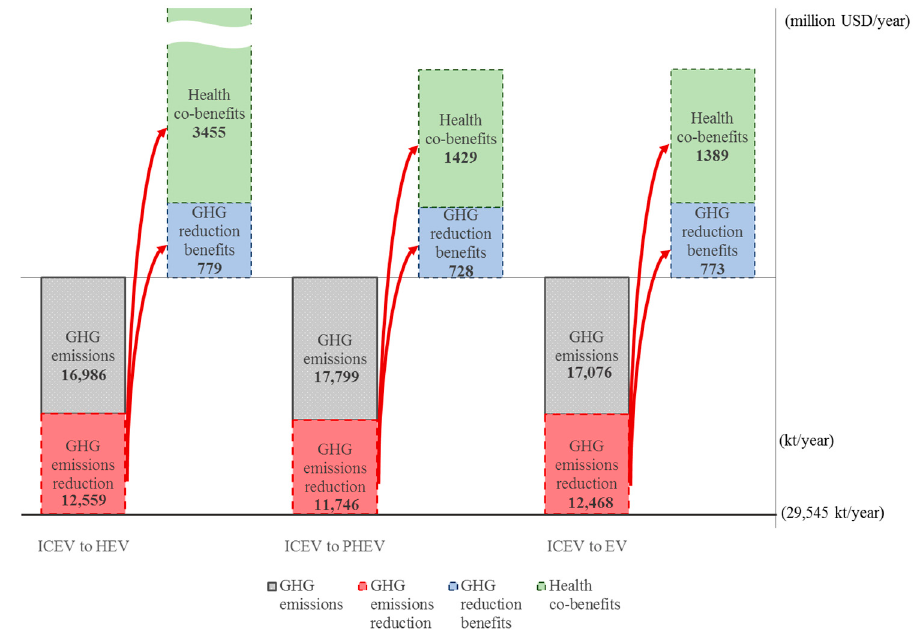
Figure 2. GHG reduction benefits and the health co-benefits from changing internal combustion vehicles to electric vehicles.